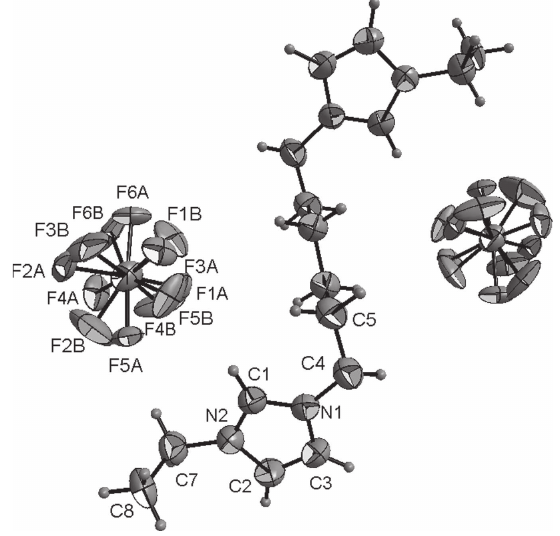
Table 1: Data collection and